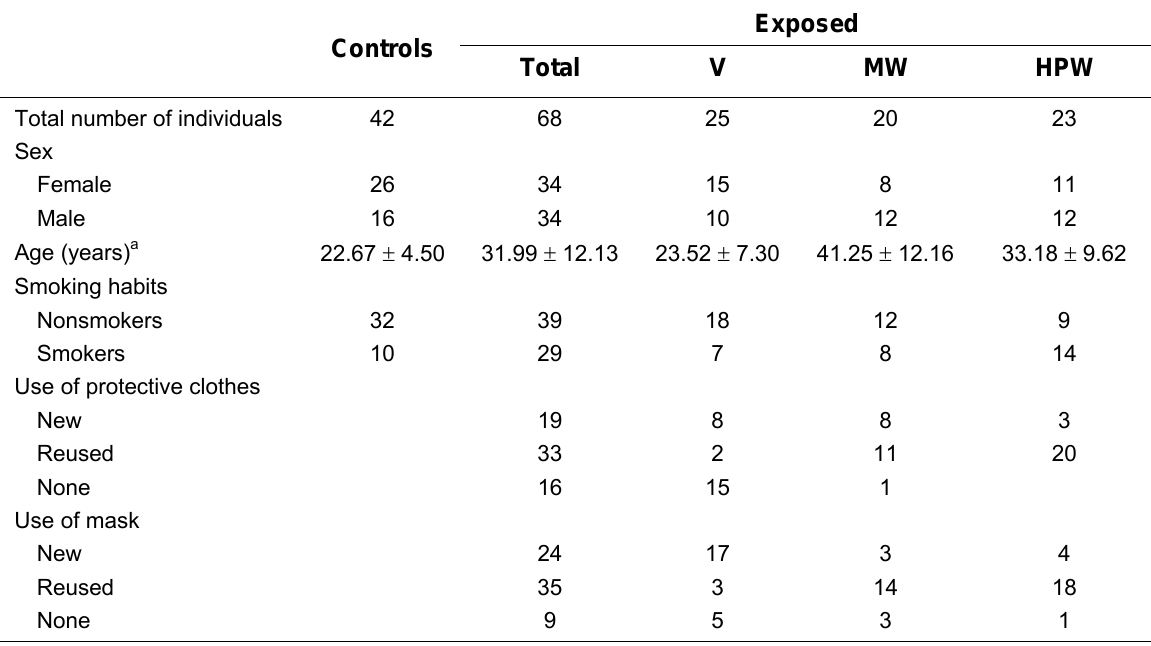
Characteristics of the Study